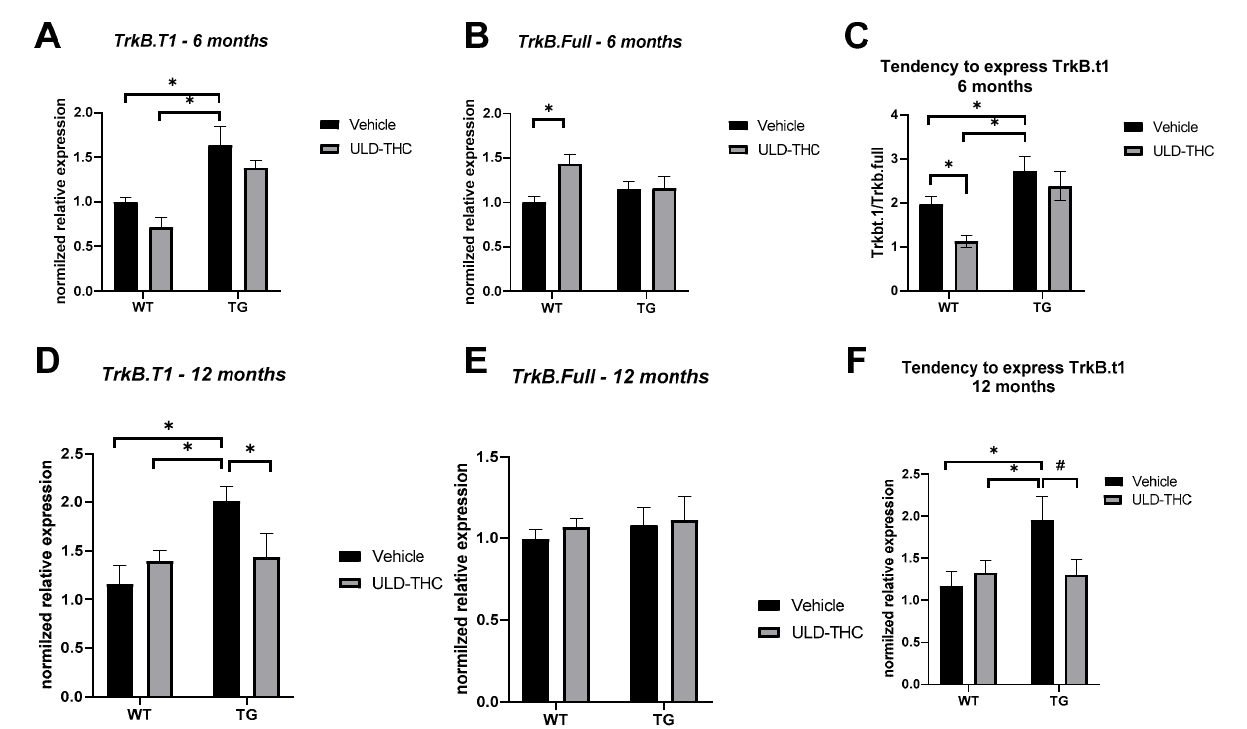
Figure 2. TrkB Neurotropic receptor imbalance. Six-month-old AD mice displayed higher TrkB.T1 expression in RT-PCR compared to WT mice, while no such upregulation was observed between the AD mice ( A ). There was no difference in the gene expression levels of TrkB-full receptor between AD mice and WT mice, although we did see an upregulation in the ULD-THC-treated WT mice compared to the non-treated WT mice ( B ). Non-treated AD mice had a higher ratio of expressed TrkB.T1: TrkB-full compared to WT mice, while no such tendency was observed in treated AD mice ( C ). 12-month-old AD mice displayed higher TrkB.T1 expression compared to WT mice, while no such upregulation was observed between the treated AD mice ( D ). There was no difference in the gene expression levels of TrkB-full receptor between AD mice and WT mice, although we did see an upregulation in the ULD-THC-treated WT mice compared to the non-treated WT mice ( E ). Non-treated AD mice had a higher ratio of expressed TrkB.T1: TrkB-full compared to WT mice, while no such tendency was observed in treated AD mice ( F ). * indicates p > 0.05. # indicates p = 0.08 Mean ± SEM.